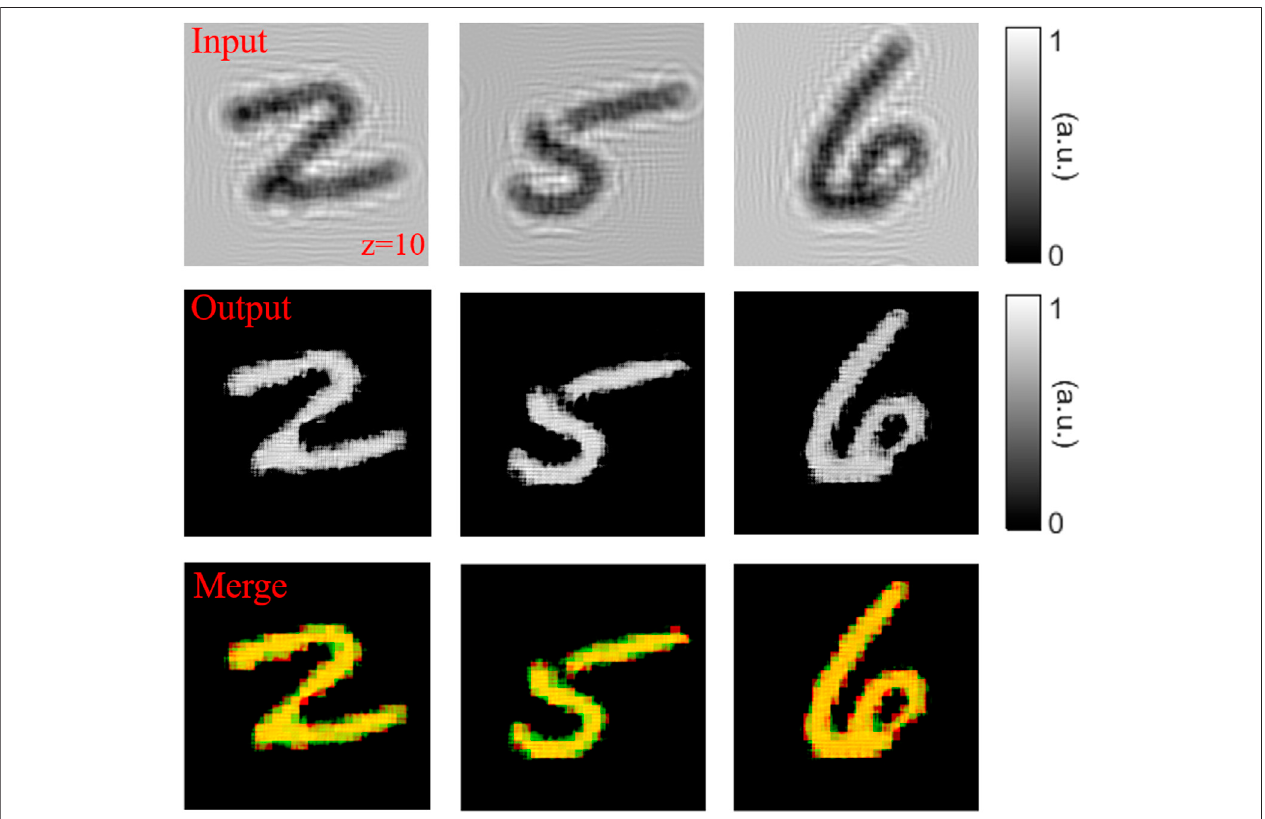
FIGURE 3 | Acoustic hologram reconstruction results of different acoustic targets are utilized to evaluate the feasibility of the PhysNet-AH. The fi rst row shows the diffraction-limited acoustic fi eld intensity from the holograms for digits 2, 5, and 6 at z = 10 mm, which are used as the input of the network. The second row shows the holographic reconstruction of the abovementioned acoustics fi elds, which are obtained by PhysNet-AH. The last row shows the merged images of the target digits (ground truth) and the corresponding reconstructed images. Red displays the ground truth, green corresponds to the reconstructed results of PhysNet-AH, and yellow represents their